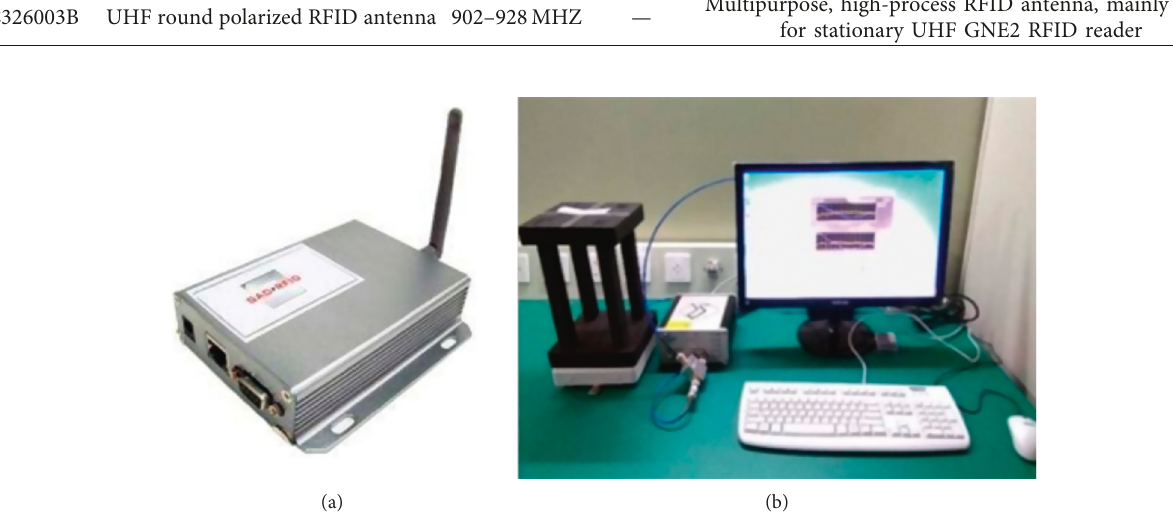
Figure 8: (a) RFID reader and (b) PC port. Table 3: Partial prefabricated component information